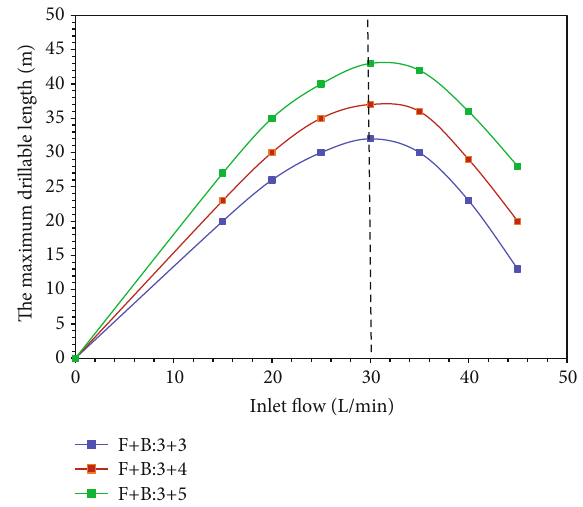
Figure 11: E ff ects of inlet fl ow on the maximum drillable length at F + B : 3 + 6 , 4 + 6 , and 5 + 6 .